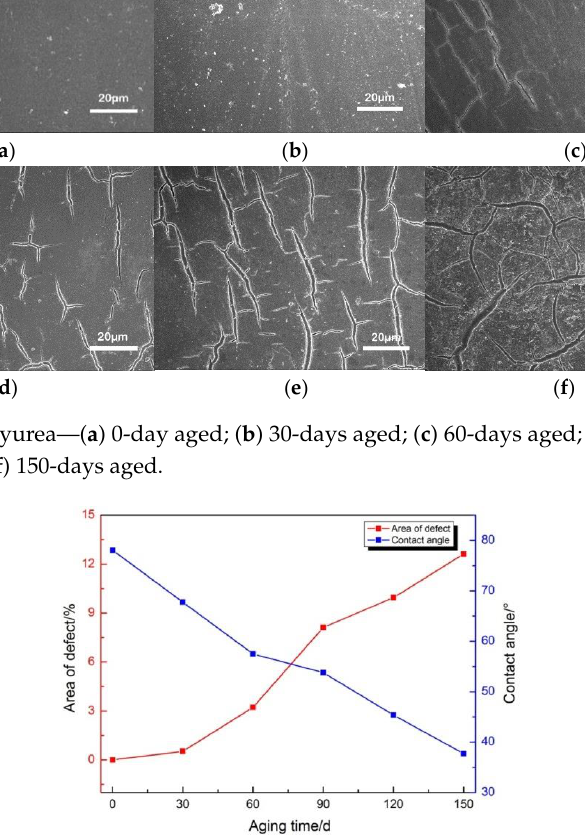
Figure 7. Correlation between the defect area and the contact angle.